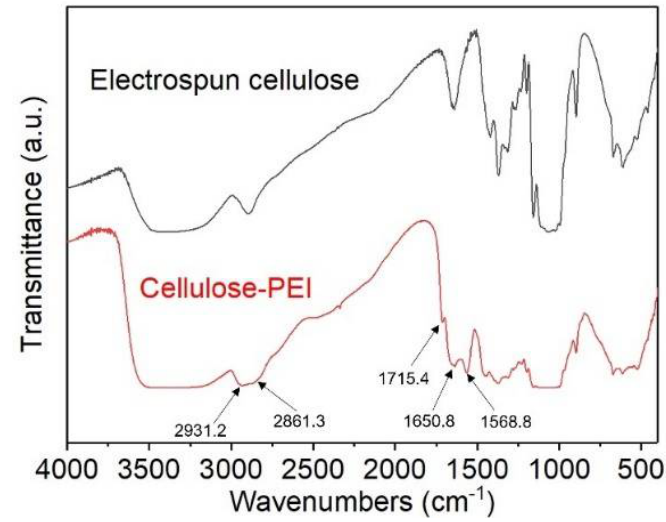
Figure 3. The FTIR spectra of neat electrospun cellulose and cellulose-PEI.